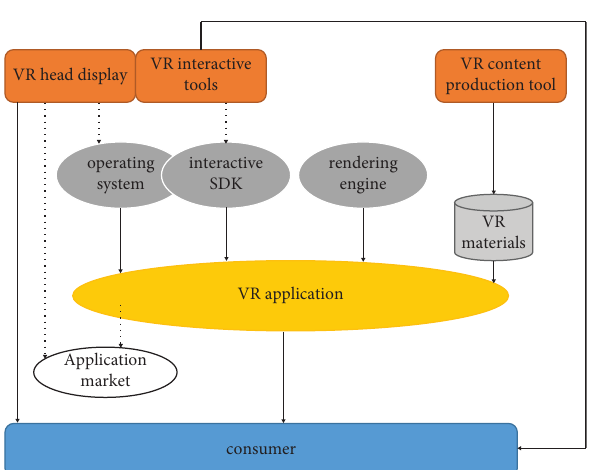
Figure 3: Application of VR simulation